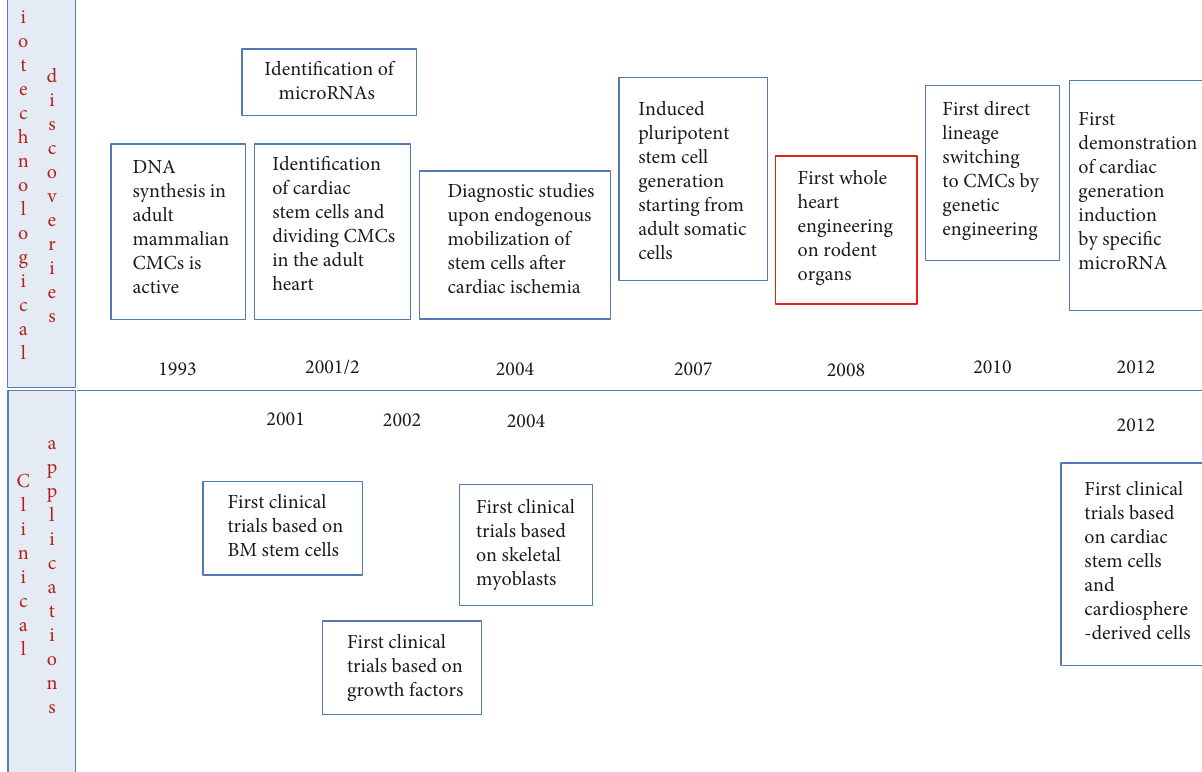
Figure 1: The most striking technological advancements and clinical applications anticipating the birth and evolution of the whole bioengineering heart concept (CMCs: cardiomyocytes; BM: bone